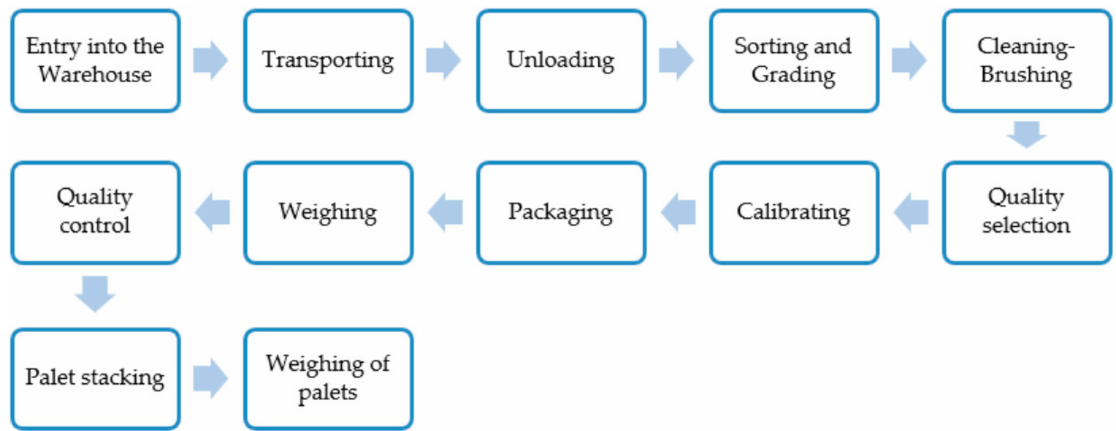
Figure 2. Handling